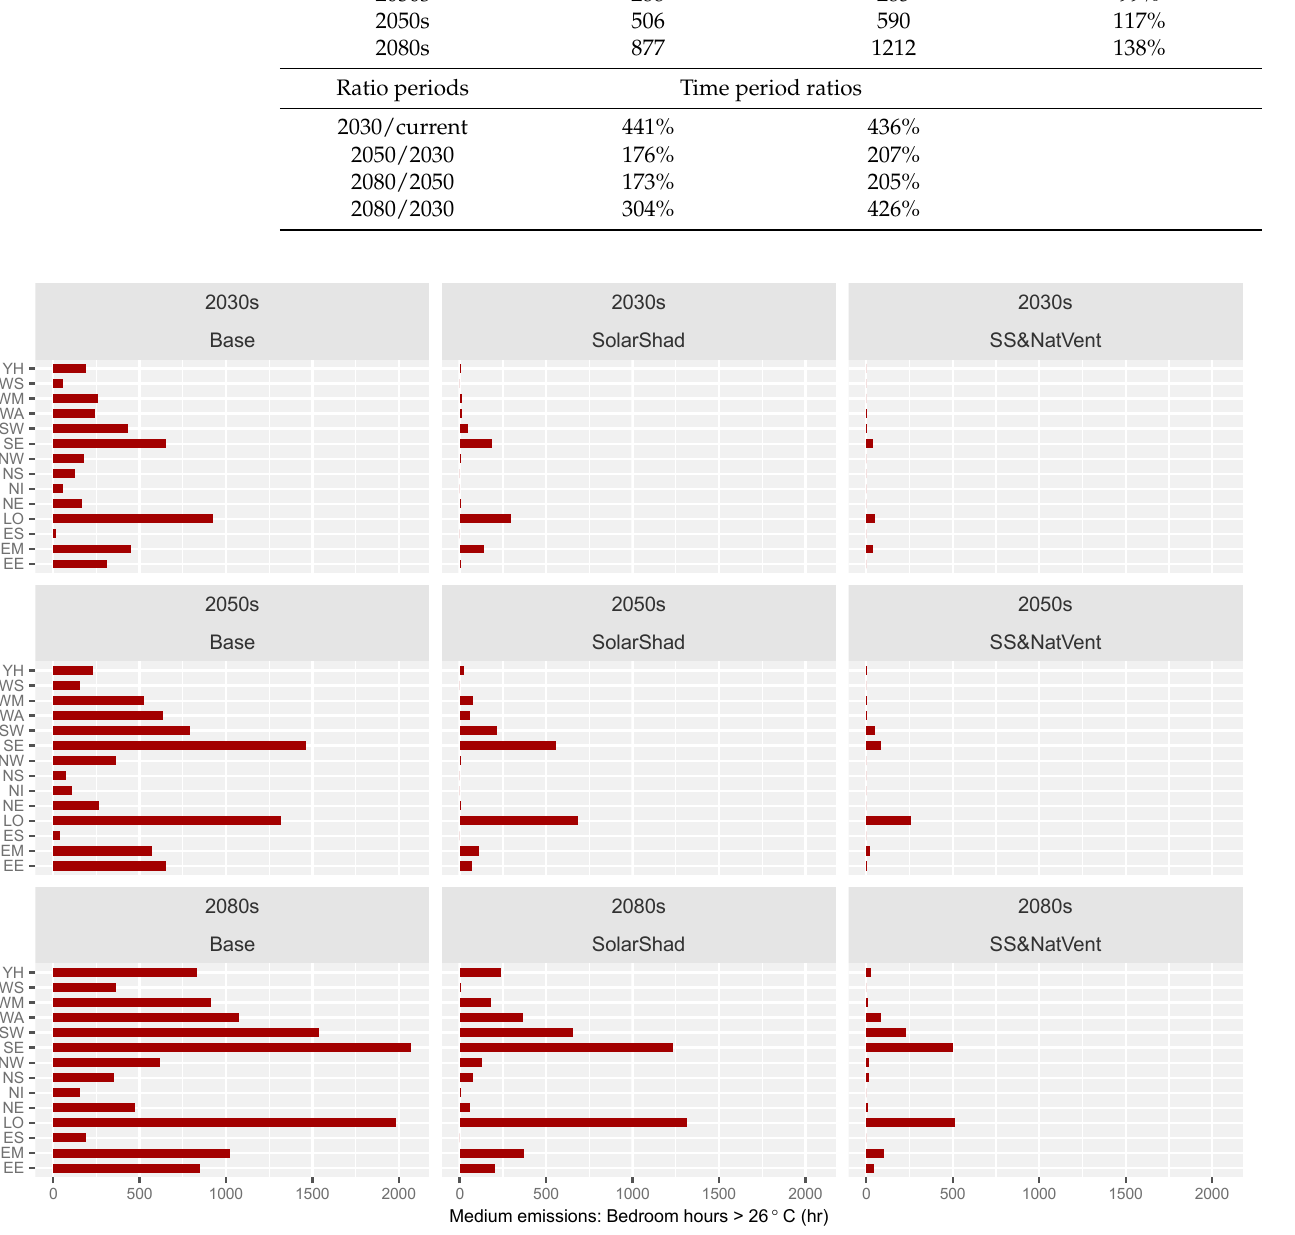
Figure 11. Results for medium-emission scenario in different decades: for base case, with solar shading (SolarShad), and solar shading combined with ventilation (SS&NatVent).